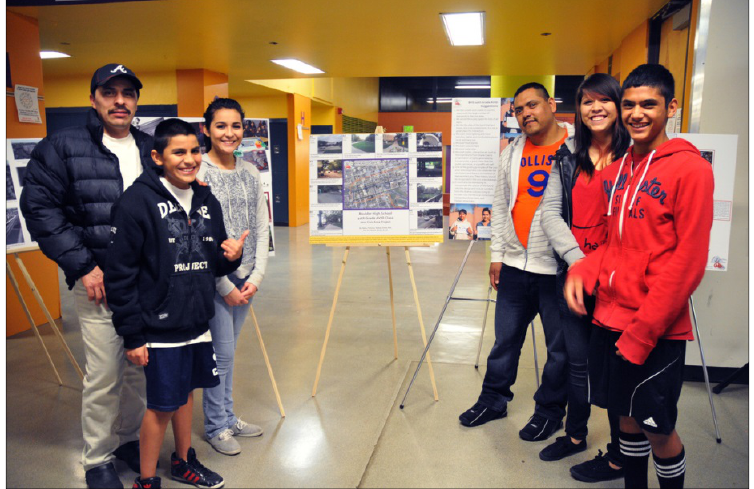
Figure 8. AVID students and parents celebrate their contributions to the Boulder Civic Area (photo courtesy Lynn M. Lickteig).